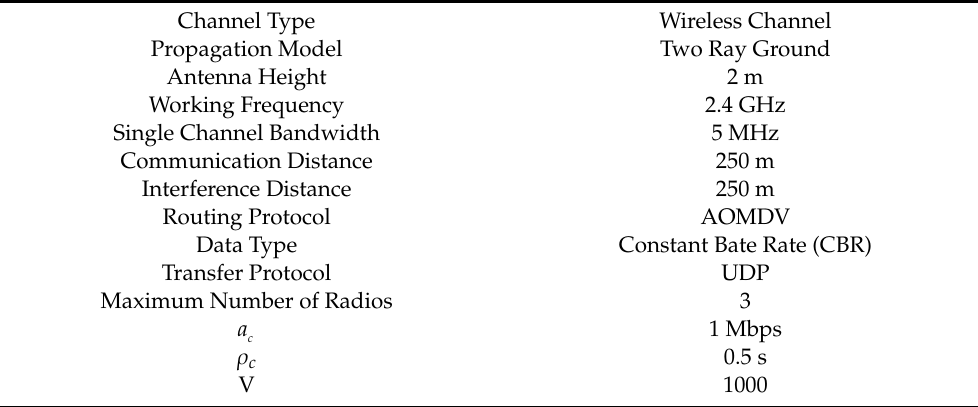
Table 2. Parameter configuration in Network Simulator 2 (NS2)